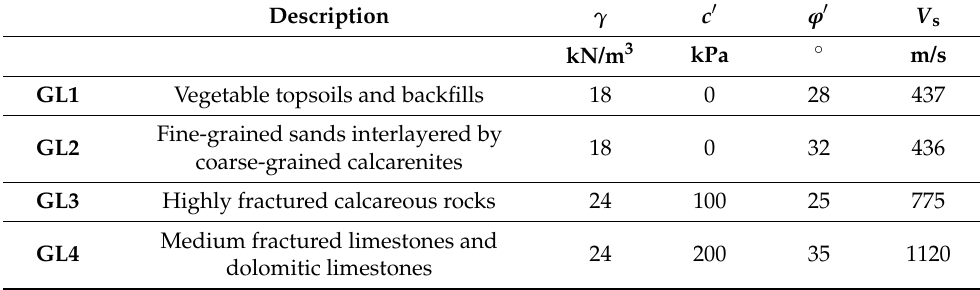
Table 1. Different materials recognized from the geotechnical